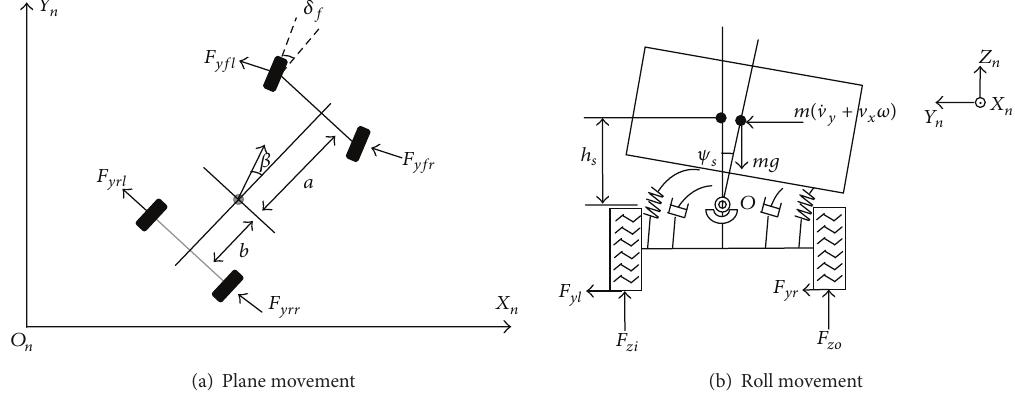
Figure 1: Schematic diagram of body movement.